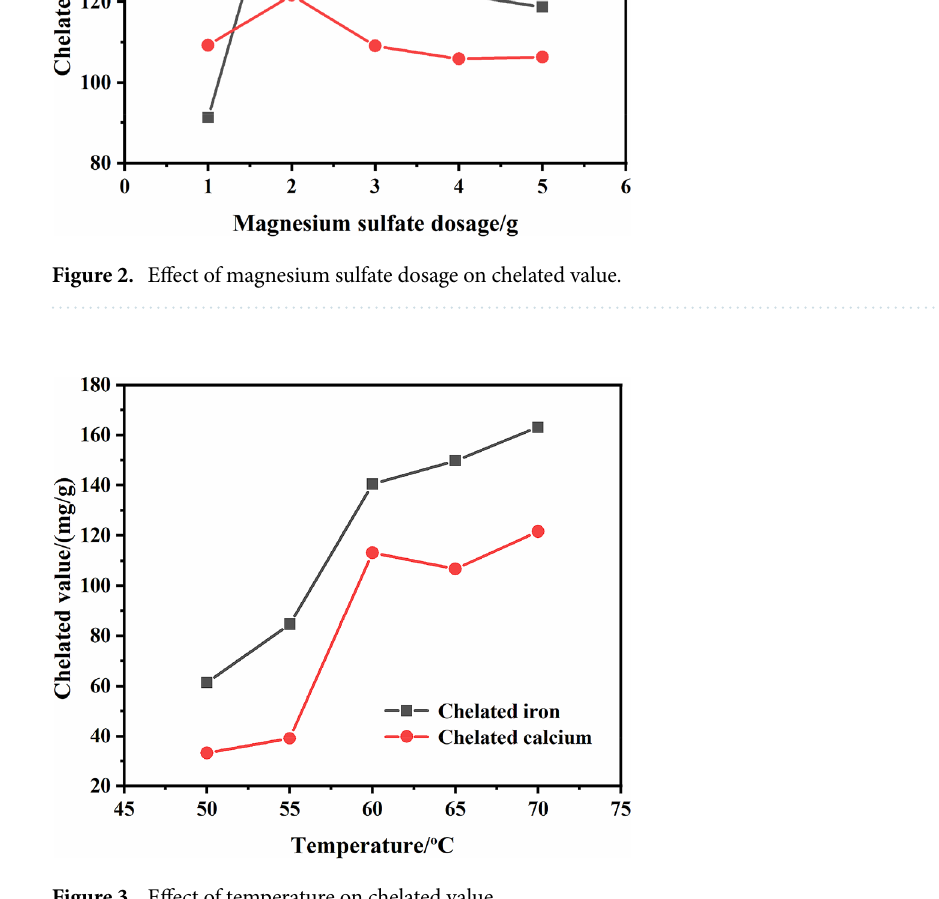
Figure 3. Effect of temperature on chelated